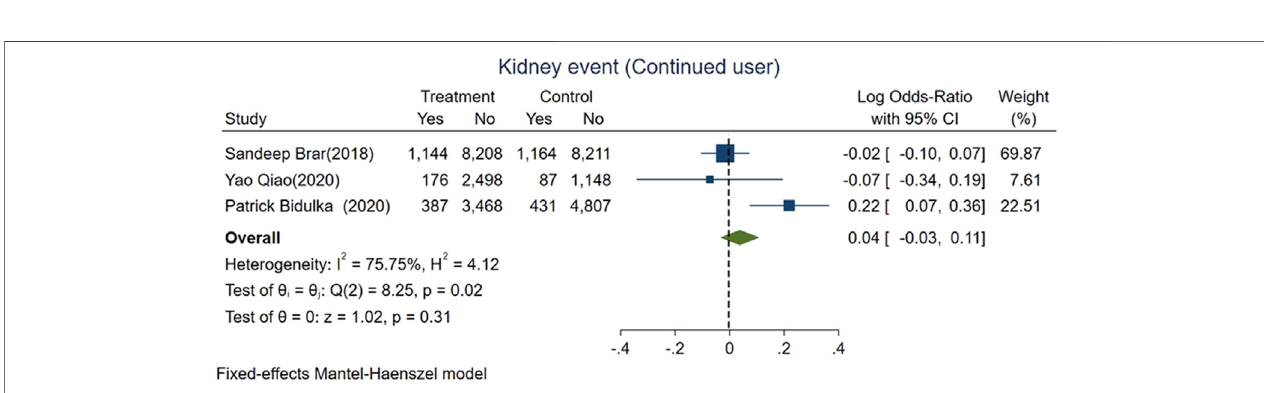
Frontiers in Pharmacology |